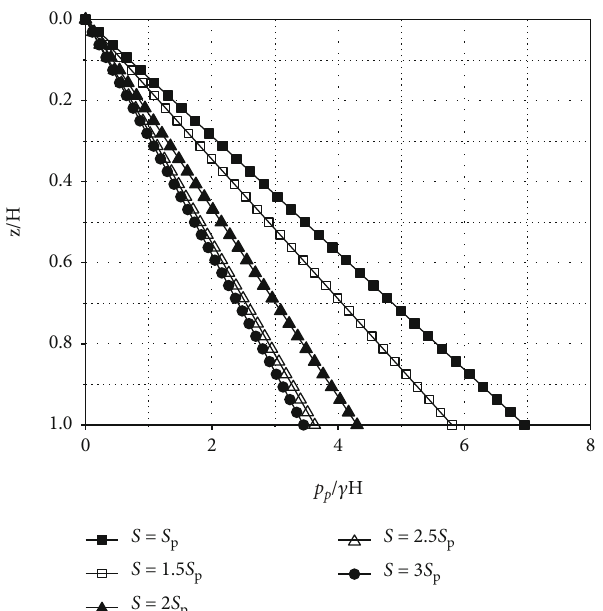
/ γ H versus z / H for the di ff erent displacements S after Figure 14: p p passive limit